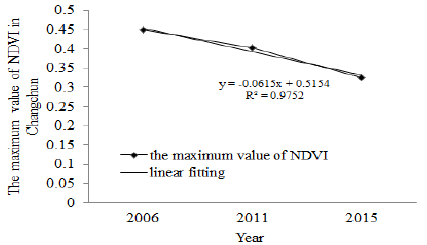
Figure 2. The changing trend graph of maximum NDVI in